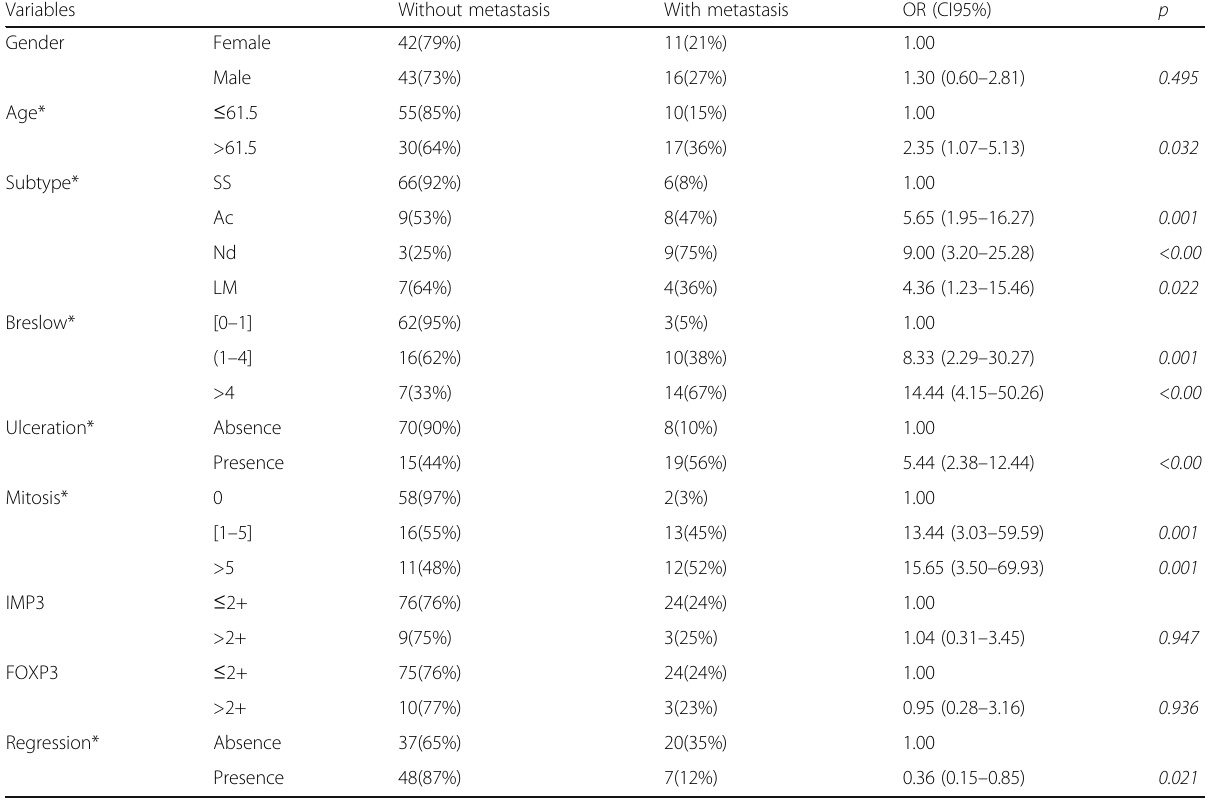
Table 1 Metastasis ’ risk related to clinical and histopathological variables